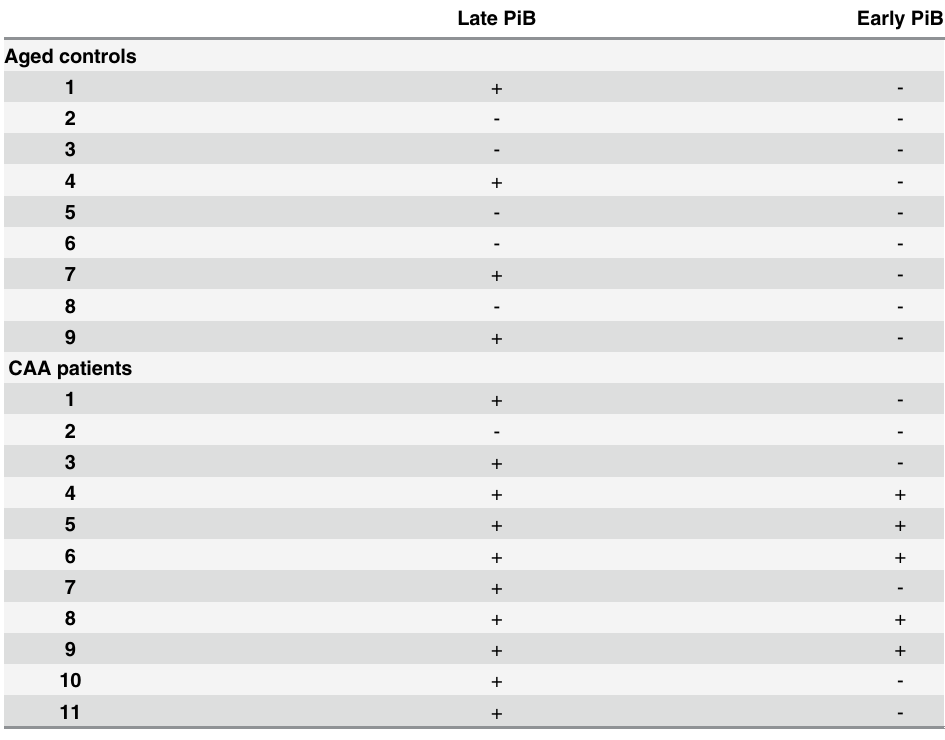
Table 1. Individual whole-cortex SUVr findings obtained with early- and late-phase 11 C-PiB-PET in age-matched healthy controls (N = 9) and CAA patients (N = 11), relative to the 95% confidence limit determined in young healthy controls (see Methods for